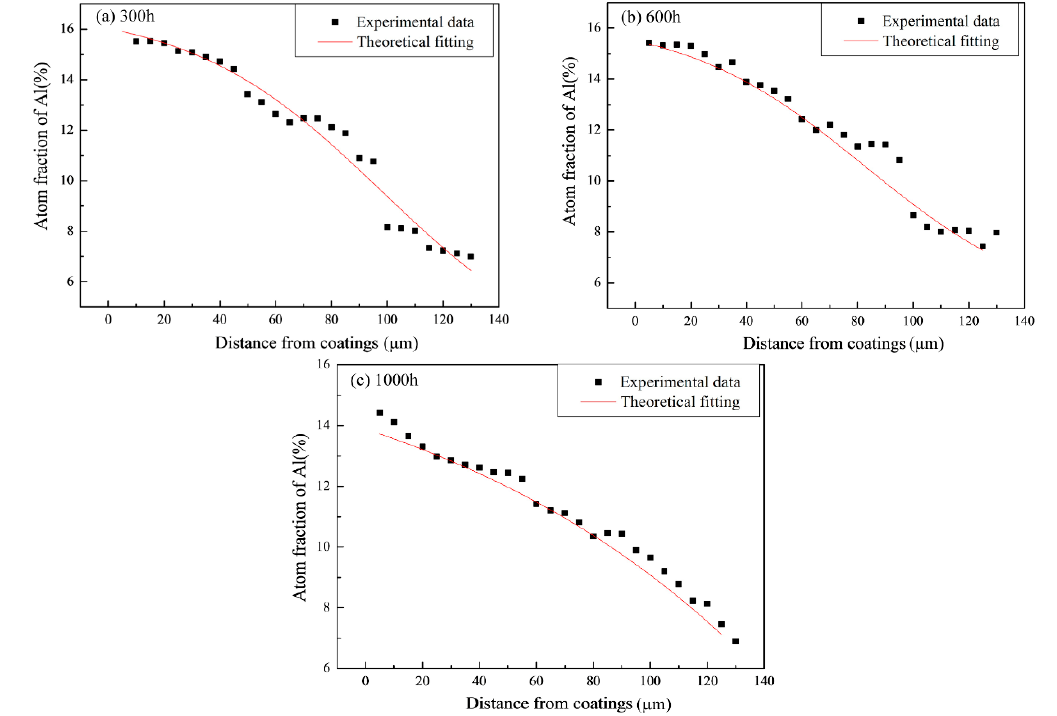
Figure 8. Concentration-fitted profiles of aluminum after thermal cyclic oxidation at 1100 °C: ( a ) 300 h; ( b ) 600 h; ( c ) 1000 h.